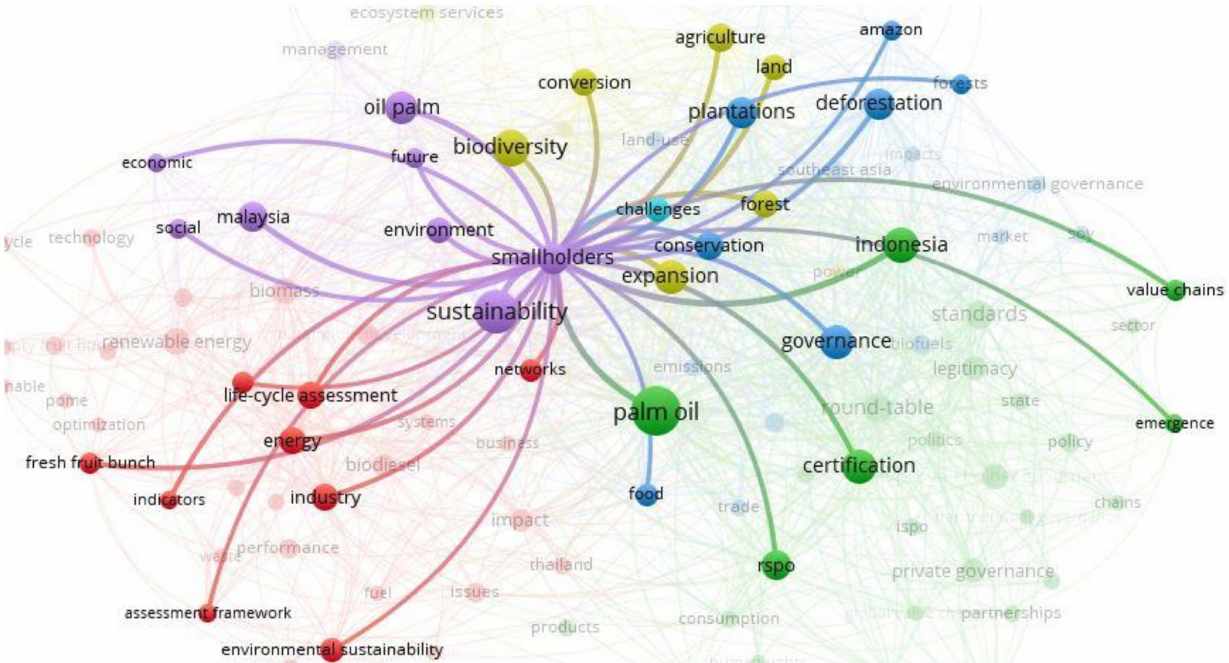
Figure 5. Research cluster linkage and inferences related to SHF.